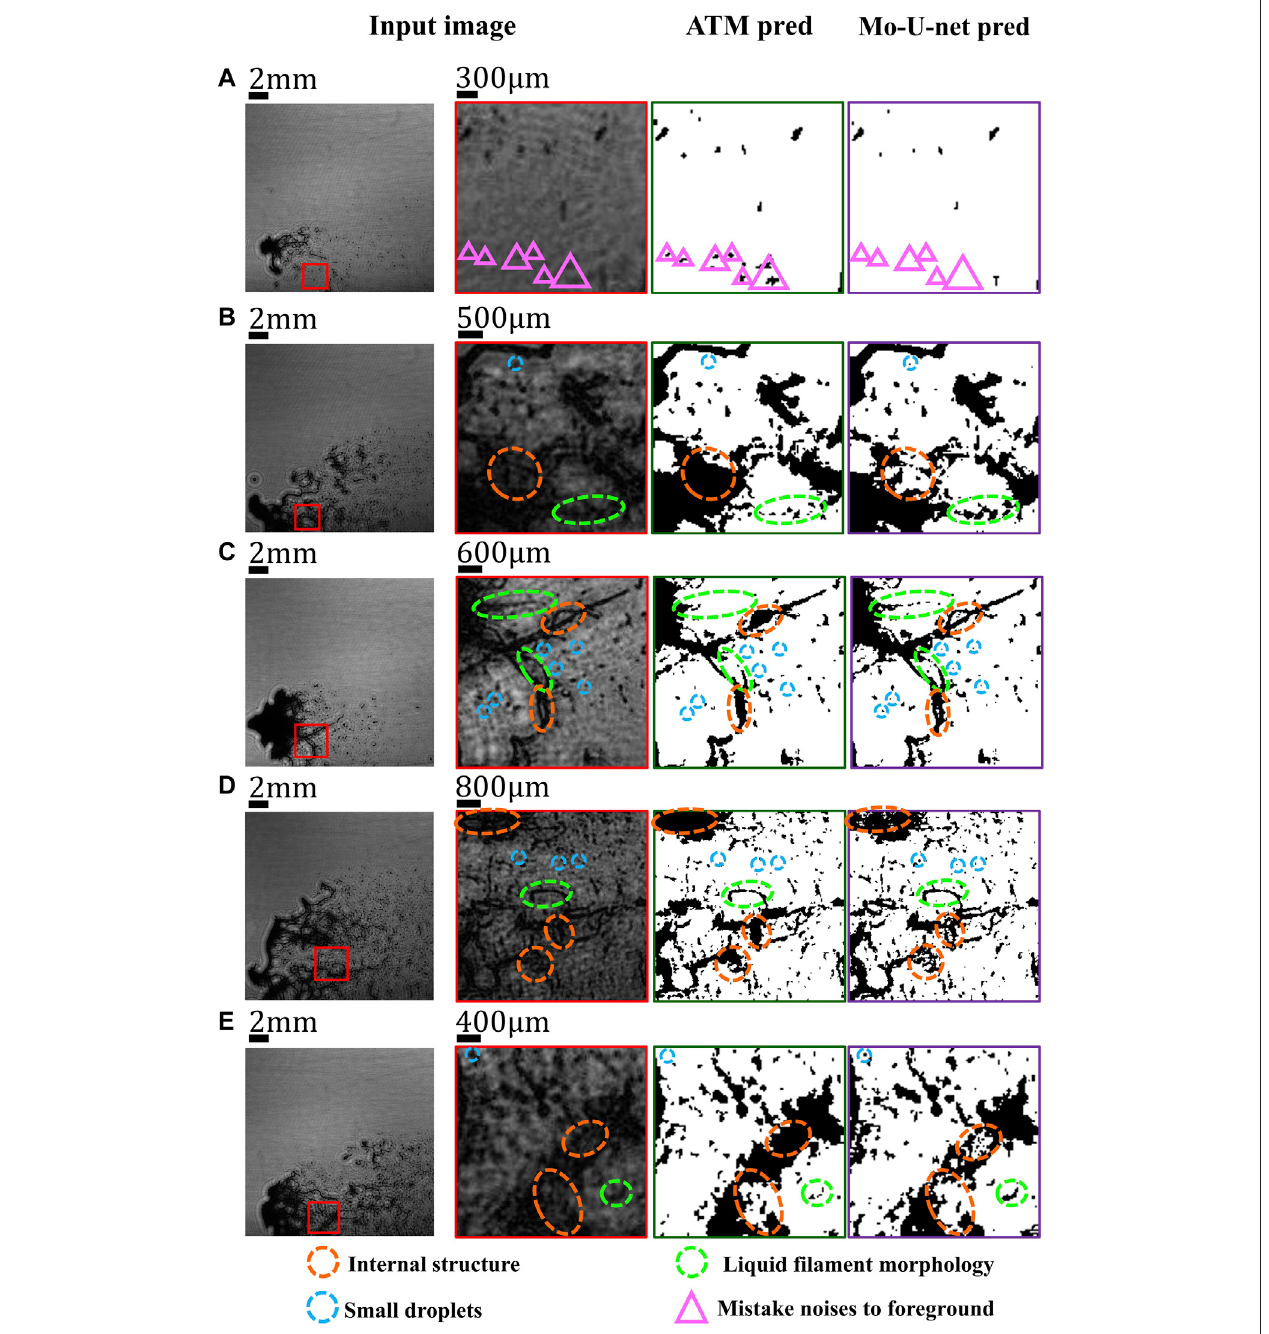
FIGURE 8 | Morphological comparison. The prediction of adaptive-threshold method is called ATM pred, the prediction of Mo-U-net is called Mo-U-net pred. The subgraphs (A) toEbelongtocase1tocase5respectively.Thesubgraphswithredboundaryaretheenlargedonesofwhattheredboxesframe,meanwhiletheblackish green refers to ATM pred and the purple denotes Mo-U-net-pred.